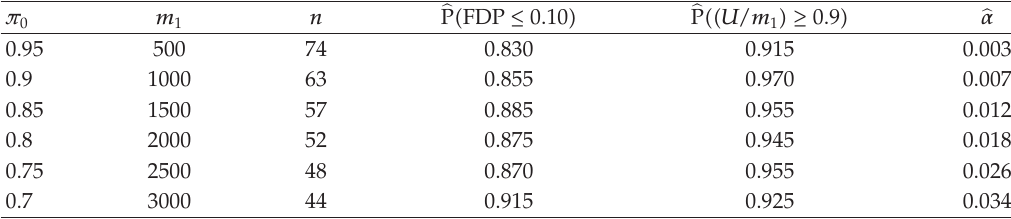
Table 4: Sample size calculation using the prostate cancer